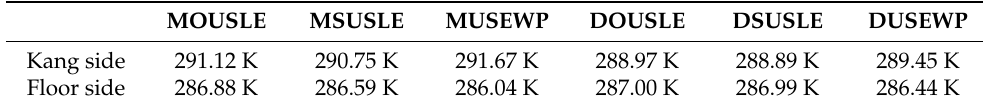
Table 8. The average temperature of the air on the kang side and the floor side when the ventilation volume is Q = 29 m 3